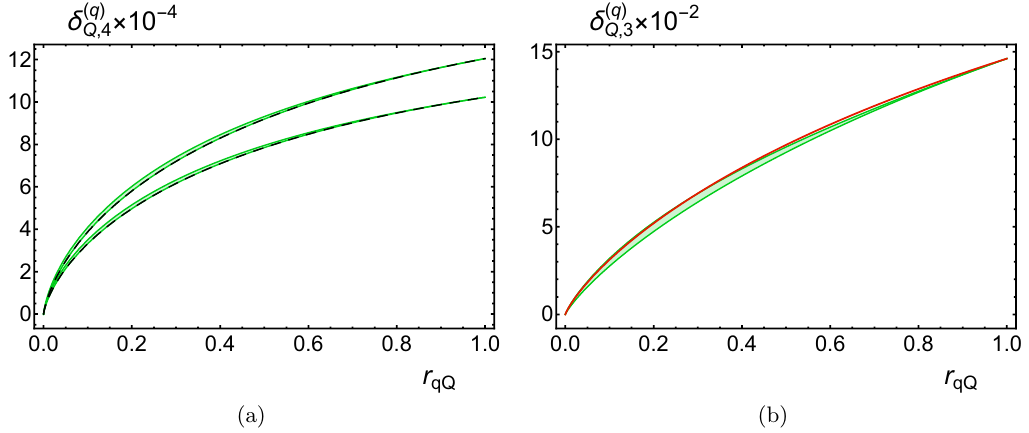
Figure 4 . (a) Prediction for the O ( (cid:11) 4 ) virtual quark mass correction (cid:14) ( q ) ( r qQ ) for m q (cid:20) (cid:22) (cid:20) m Q s Q; 4 (green bands) for n Q = n ‘ + 1 = 5 (lower band) and n Q = n ‘ + 1 = 4 (upper band). The black dashed lines show the prediction for (cid:22) = m Q which gives the simple approximation formula in eq. (3.14). (b) The O ( (cid:11) 3 ) virtual quark mass correction (cid:14) ( q ) ( r qQ ) for n Q = n ‘ + 1 = 5 (red curve). s Q; 3 The green band is the prediction for (cid:14) ( q ) ( r qQ ) using the method of panel (a) for m q (cid:20) (cid:22) (cid:20) m Q Q; 3 showing excellent agreement to the exact result within